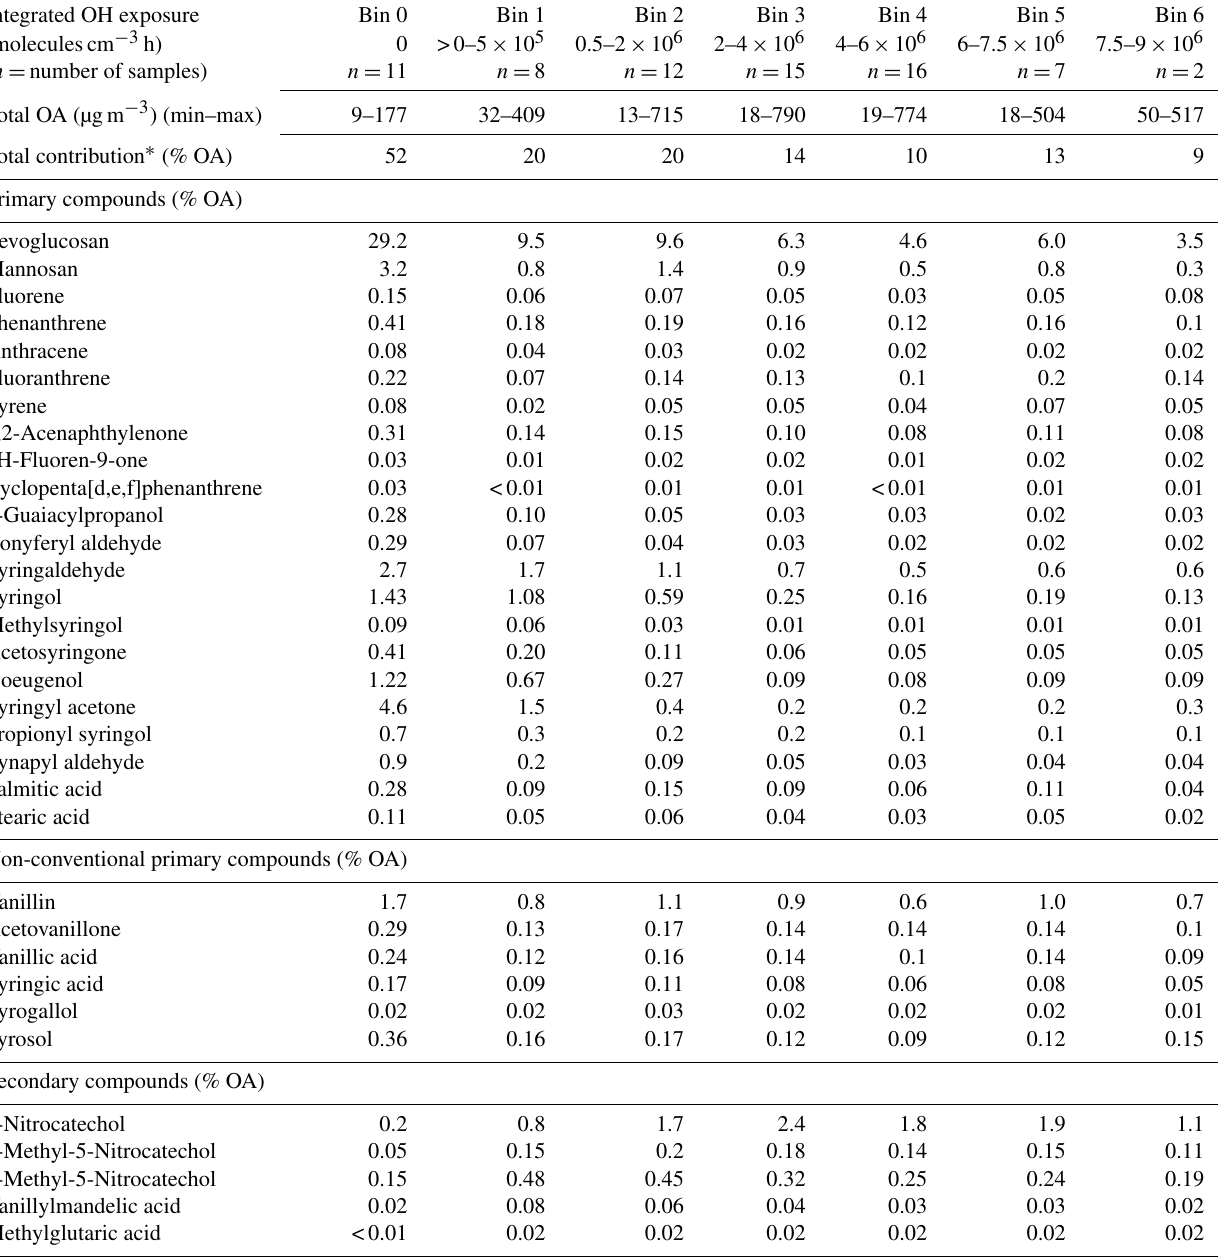
Table 2. pWLC contribution of the compounds to the total OA mass concentration at different times of the photo-oxidative process. This table only contains a list of selected compounds and average values. Data from all experiments are divided into seven bins of different integrated OH exposure intervals (from 0 to 9 × 10 6 moleculescm − 3 h) then averaged. A full list, with minimum and maximum values is also available in the